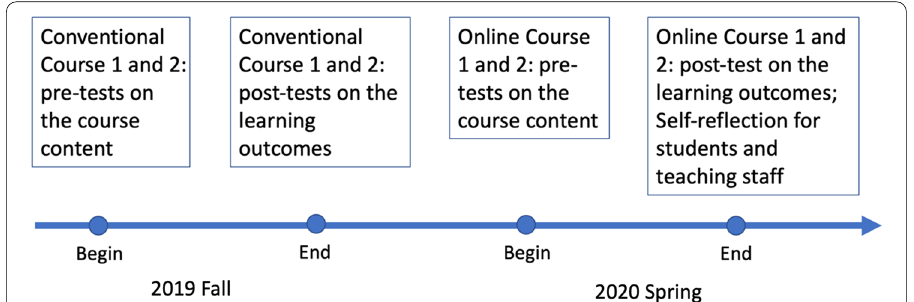
Fig. 1 Timeline of data collection: 2019 Fall (before the pandemic), 2020 Spring (during the pandemic)